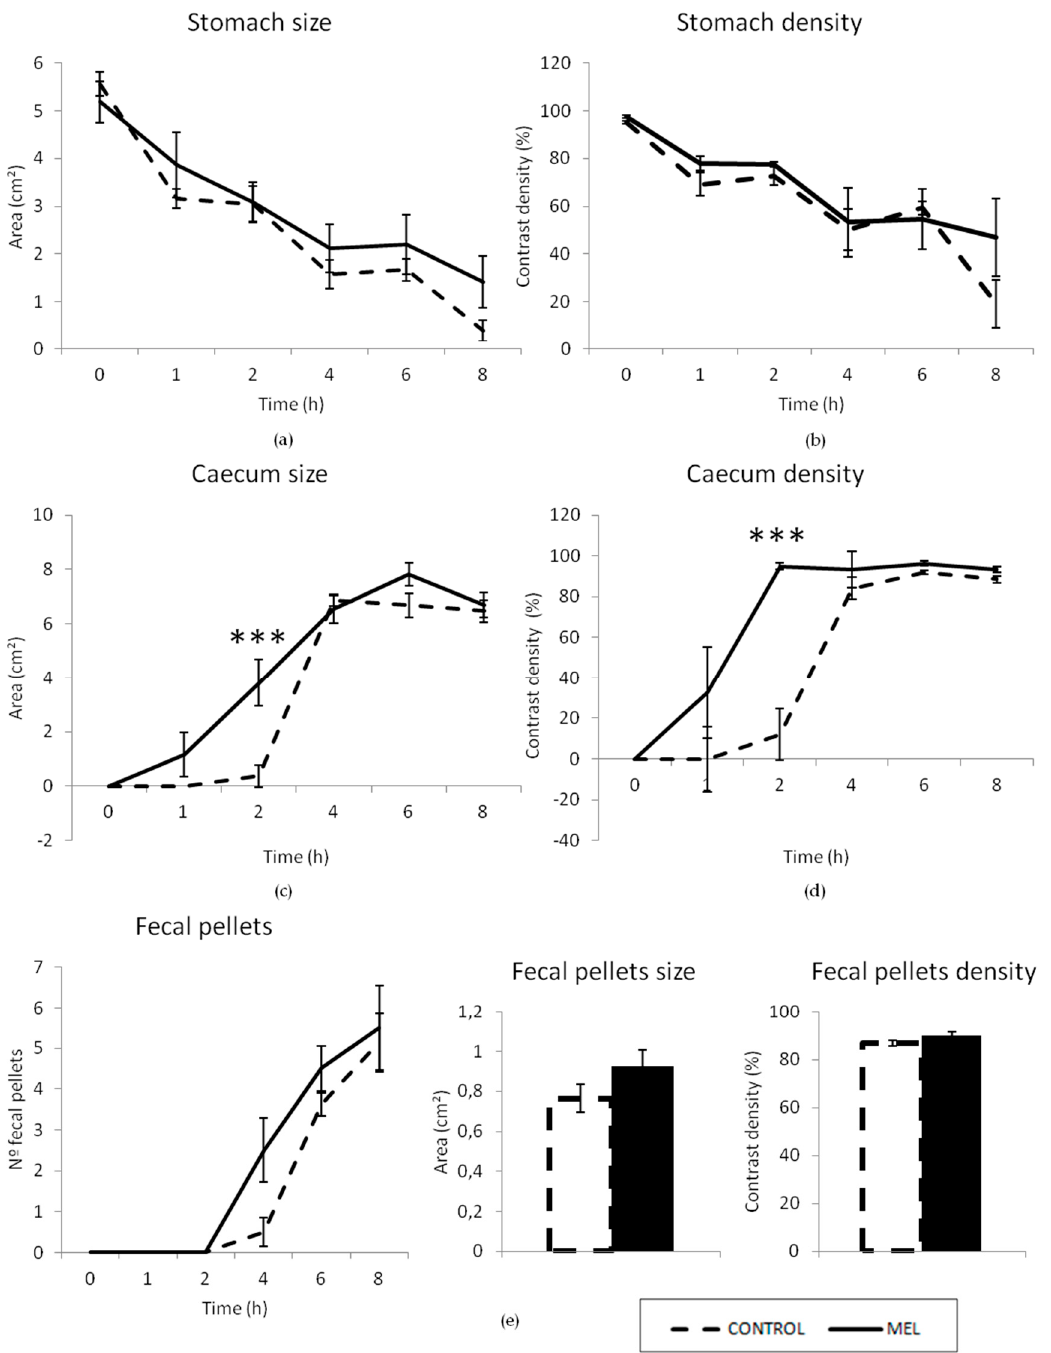
Figure 5. Radiological analysis of gastrointestinal motor function in rats—morphometric and densitometric study. A dose of barium sulfate (3 mL, 2 g/mL) was intragastrically administered at time 0, and X-rays were taken immediately and after 1, 2, 4, 6 and 8 h from time of administration. Morphometry and densitometry analyses of the stomach ( a , b ), caecum ( c , d ), and fecal pellets ( e ) are shown for the control rats ( n = 8) and the rats treated with MEL (4 g/L) ( n = 6). Size and density were evaluated using Image J (see text for details). Data represent the mean ± SEM. *** p < 0.001. (Line graphs: Two-way ANOVA followed by Bonferroni post-hoc test. Bar graphs: Student’s t -test). There were no statistically significant ( p > 0.05) differences in the lengths of the small intestine